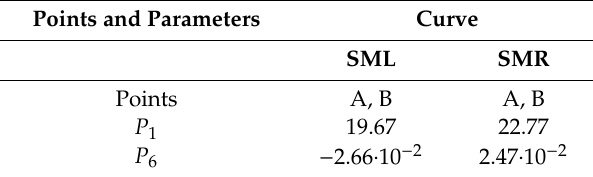
Table 14. P 1 and P 6 for the 9S20 decreasing first-order reversal curves. Points and Parameters Curve